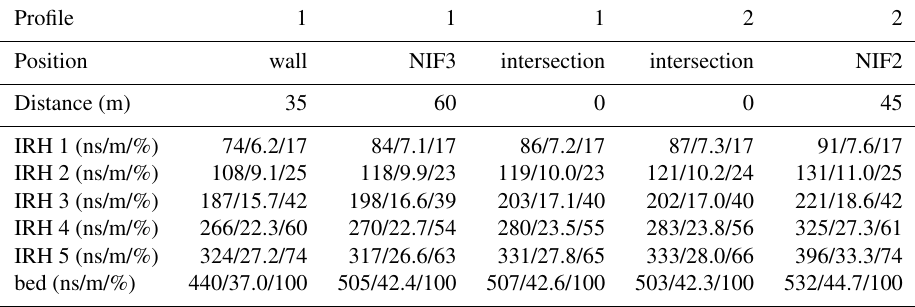
Table 3. Two-way travel times and (absolute and relative) depths of internal reflections (IRH) traced between the ice core drilling sites NIF2 and NIF3 and the vertical wall sampling site (“wall”). Horizontal distances are measured along the profiles from their intersection. Profile numbers refer to the legend in Fig. 4.